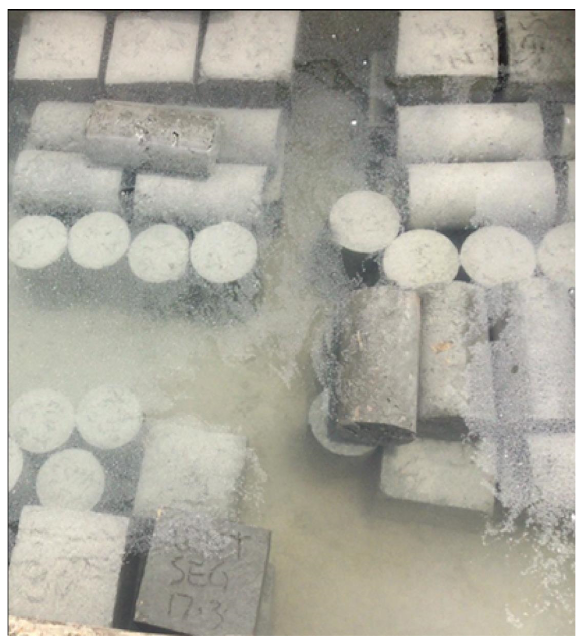
Figure 2: Curing of concrete samples in the water